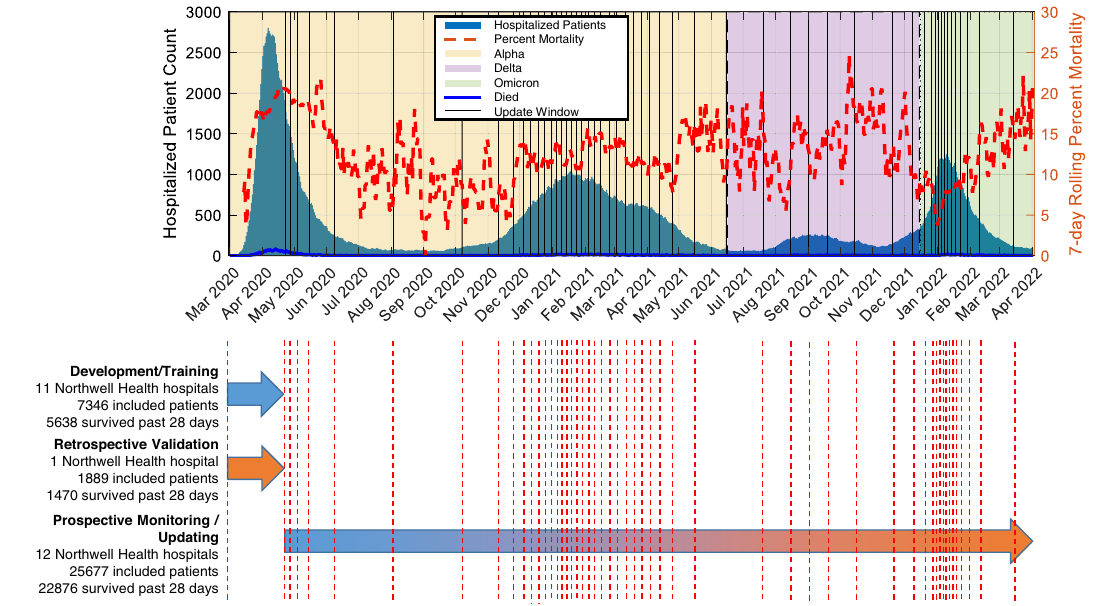
Fig. 1 | Dataset overview and study design. The data sets include training, ret- rospective validation, prospective monitoring/updating comprising 34,912 patients.Thenumberof hospitalized patientsacrossthecourse of the pandemicis plottedasbluebars,withthe7-dayrollingaveragemortalityplottedasareddashed